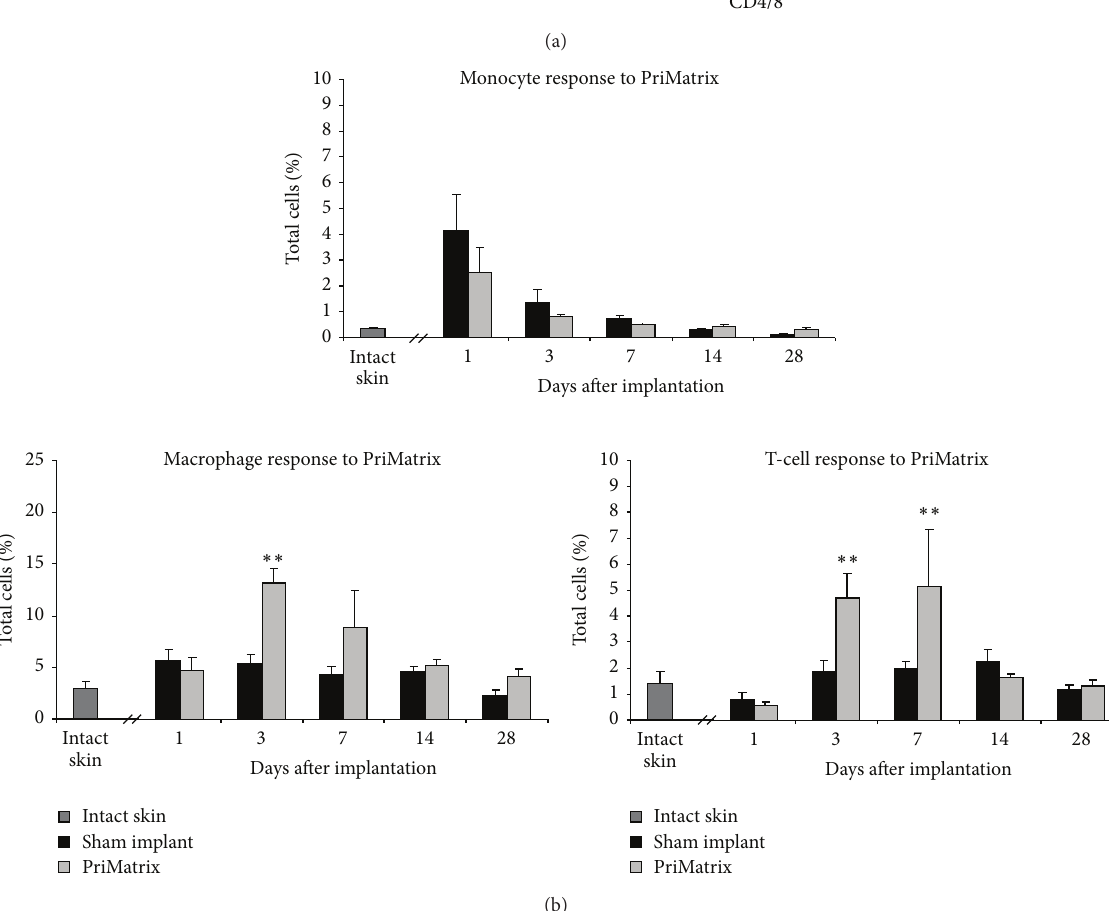
Figure 5: Flow cytometric analysis of the immune response to PriMatrix implants. (a) Gating scheme for monocyte, macrophage and T-cell analyses. (b) Quantification of the monocyte, macrophage and T-cell response, demonstrating an initial monocyte response on day 3, which transitions to a macrophage and T-cell dominated response at days 3 and 7. This inflammatory response was completely resolved by day 14, consistent with an adaptive tolerance to the implant. ∗∗ Significant compared to intact skin and sham implant